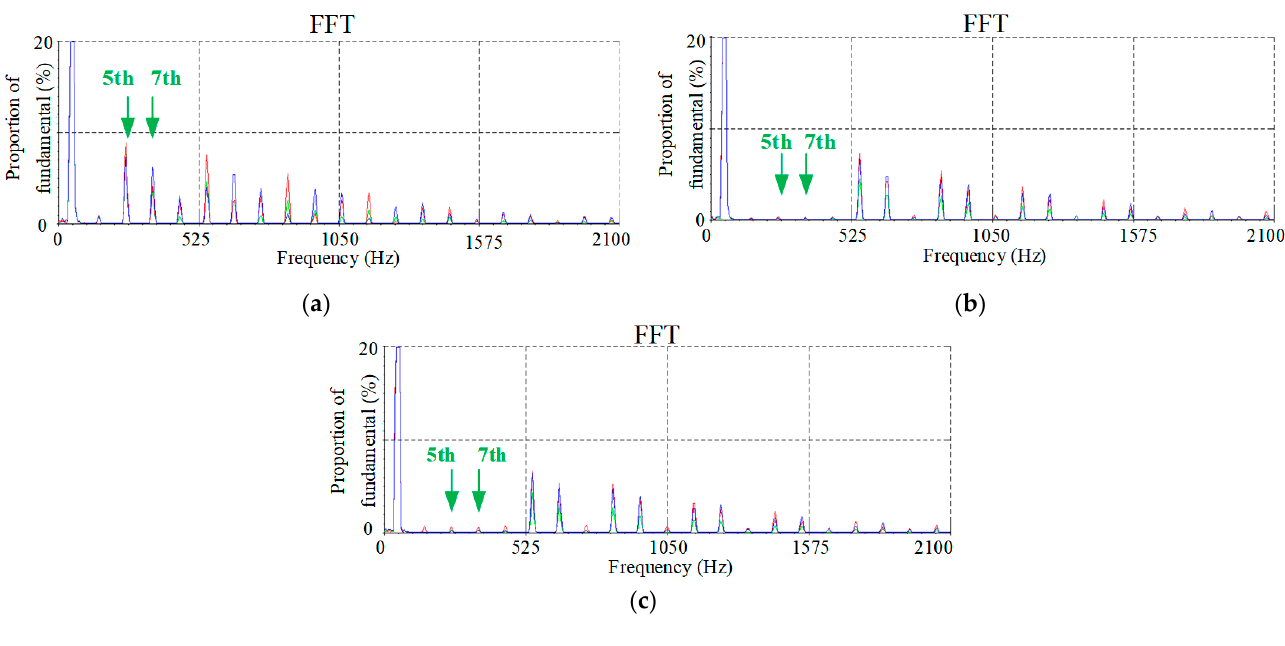
Figure 12. Experimental results for the FFT analysis harmonic waveform ( a ) with the traditional PI control strategy; ( b ) with the harmonic and imbalance voltage suppression of multi-inverter parallel VSG; ( c ) with the harmonic and imbalance voltage suppression of multi-inverter parallel VSG adding a secondary control strategy.